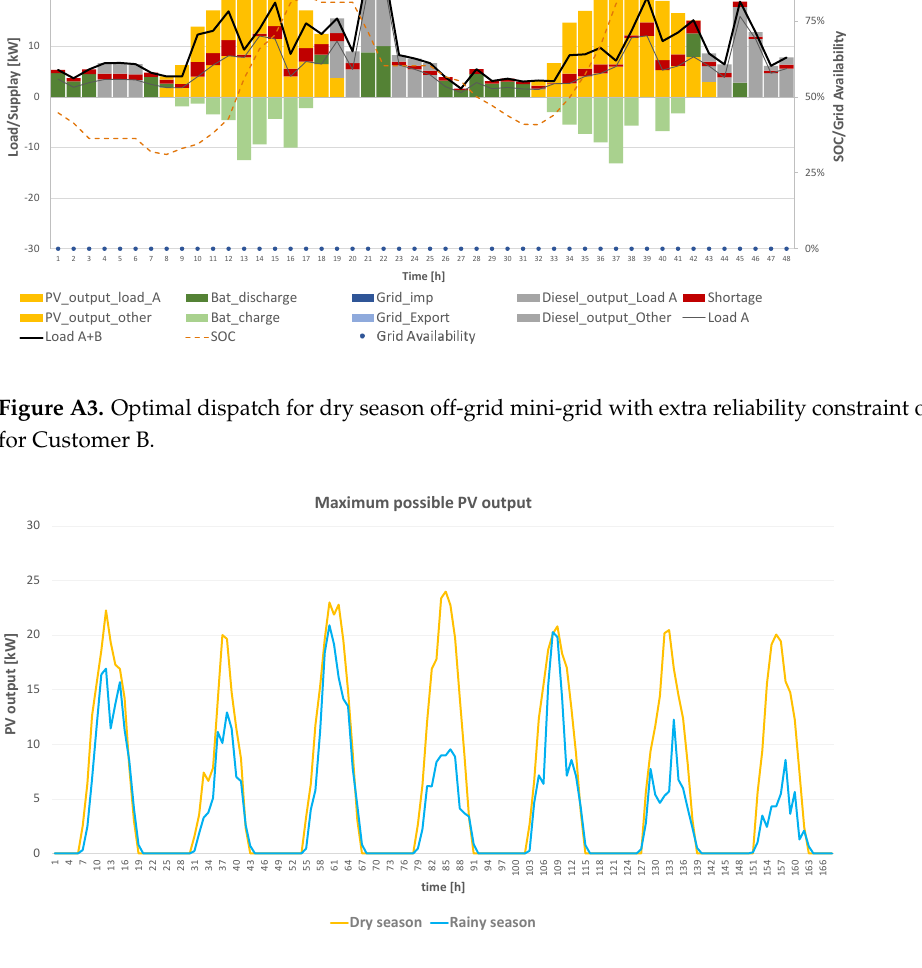
Figure A4. Maximum PV output for a rainy and a dry season week for Section 6.